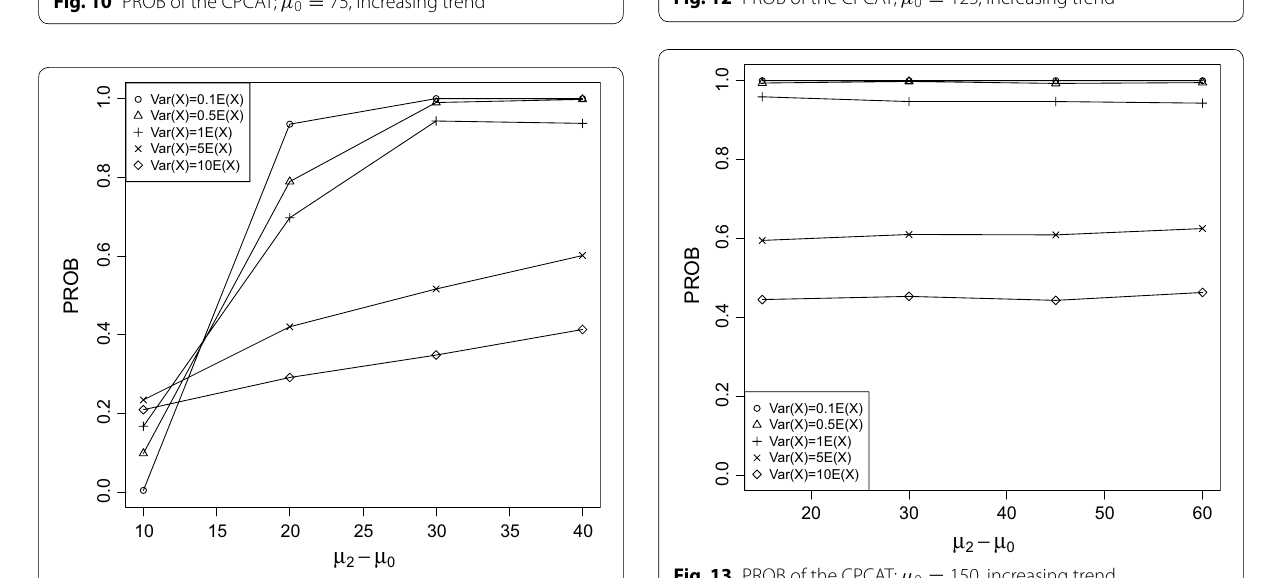
Fig. 10 PROB of the CPCAT; µ 0 = 75 , increasing trend